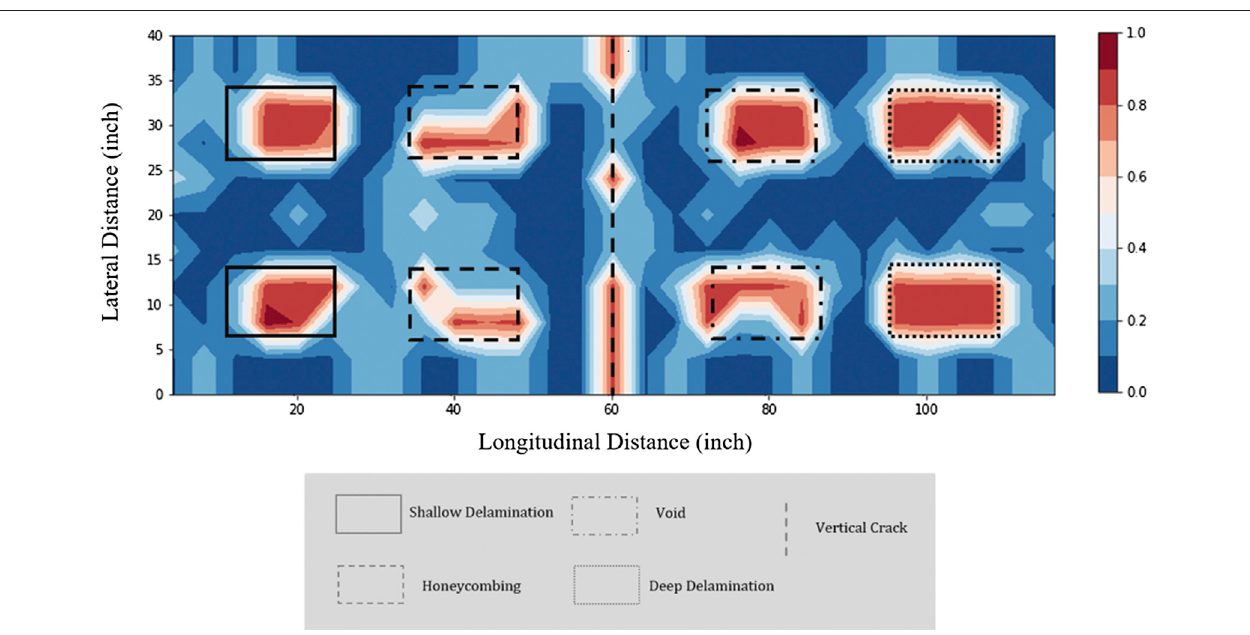
FIGURE 13 | Support Vector Machine fusion heat map indicating the existence and extents of delamination and cracking.